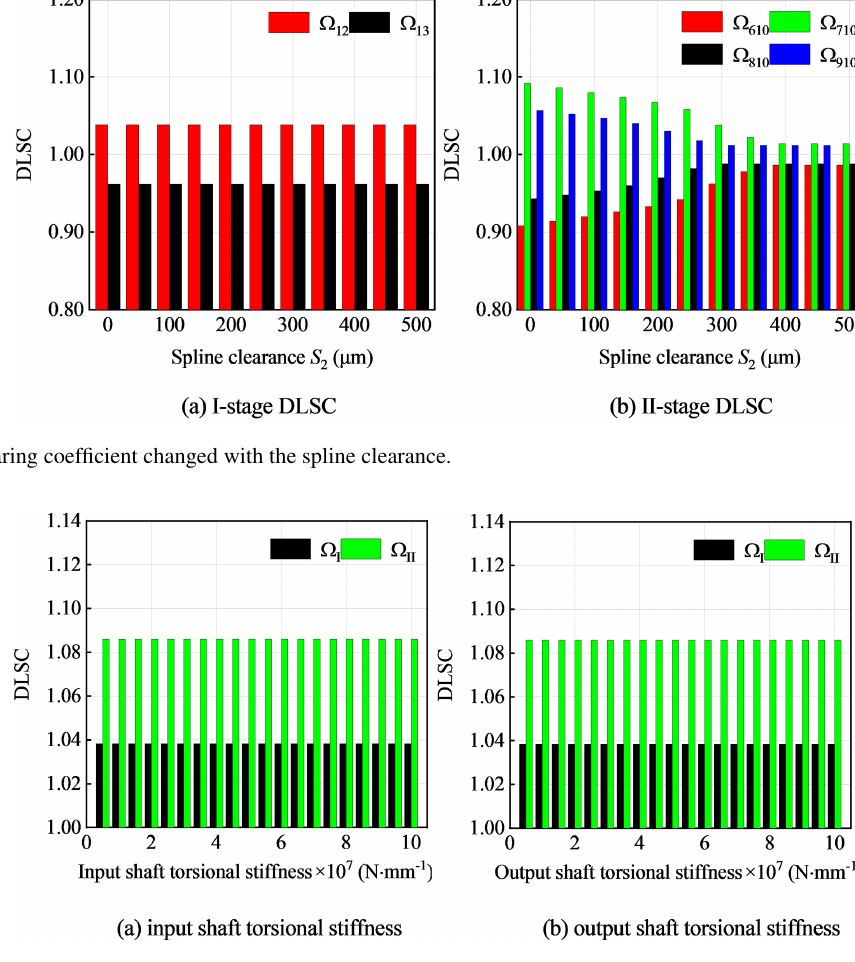
Figure 16. Influence of input and output shaft torsional stiffness on dynamic load-sharing